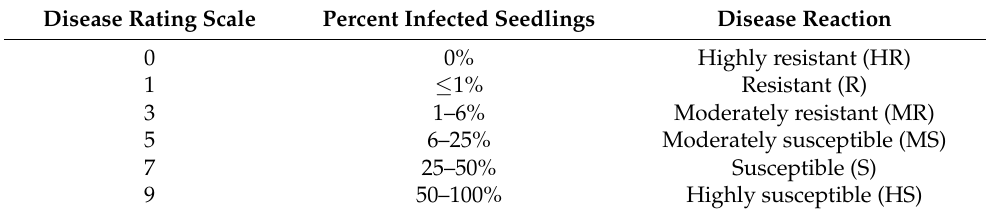
Table 5. Bakanae disease evaluation method according to the standard evaluation system of the International Rice Research Institute